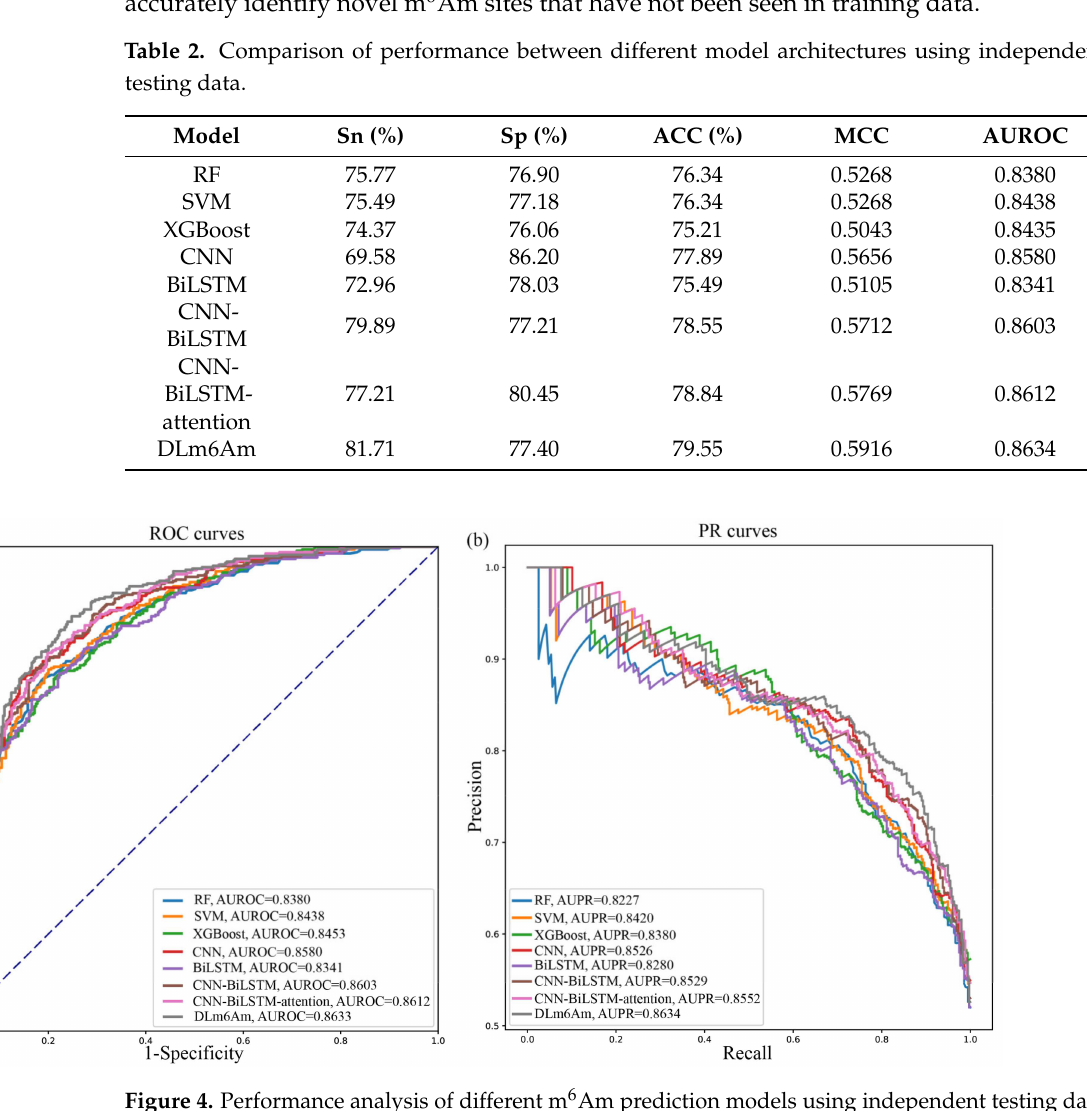
Figure 4. Performance analysis of different m 6 Am prediction models using independent testing